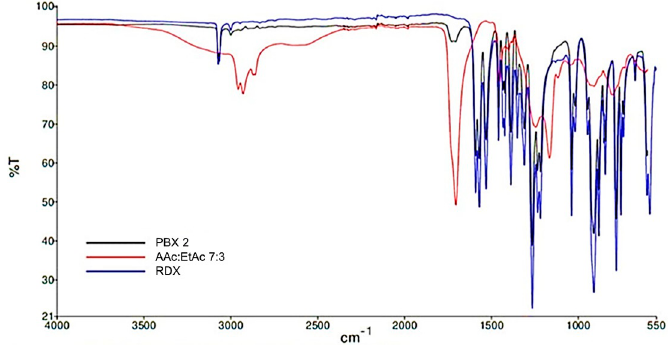
Figure 3. FT-IR spectra for the RDX, copolymeric binder, and PBX 2.